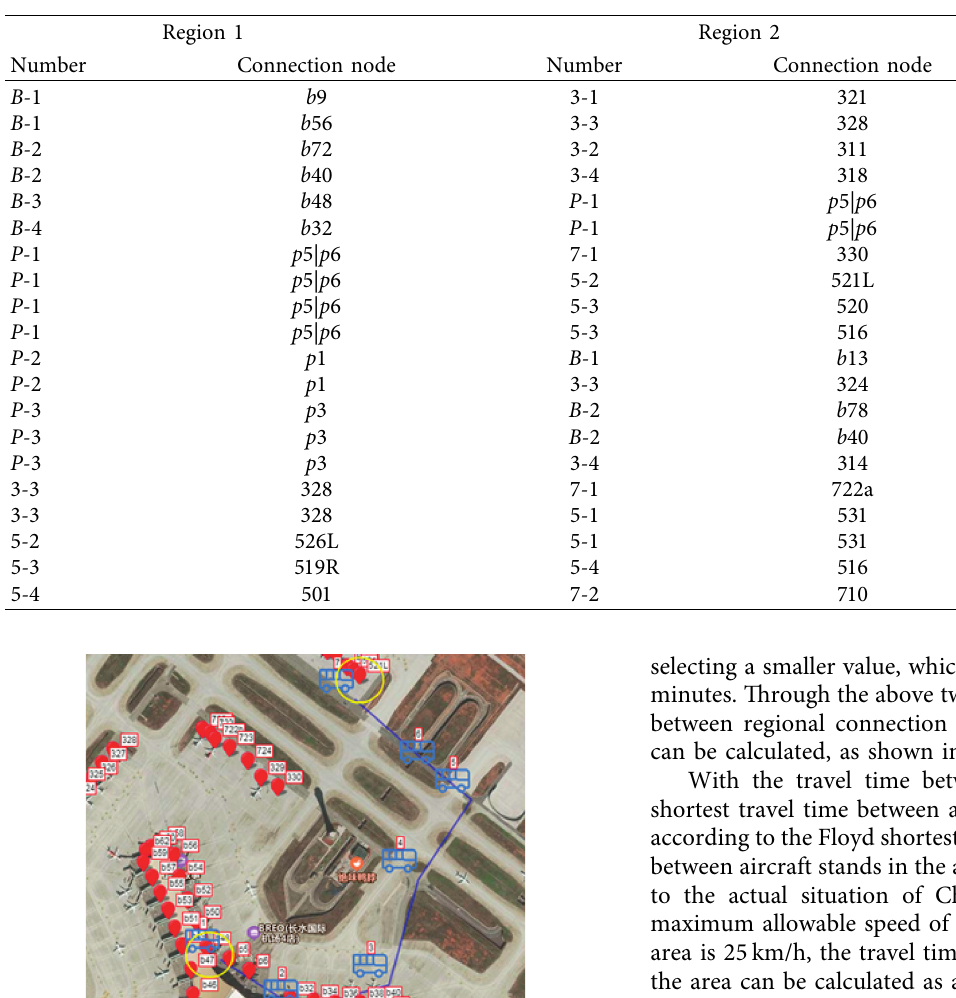
Table 5: Distances between areas in the road network.